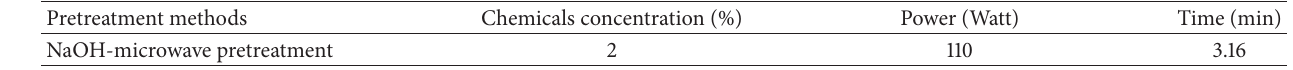
Table 3: Optimum conditions for delignification of rice straw.